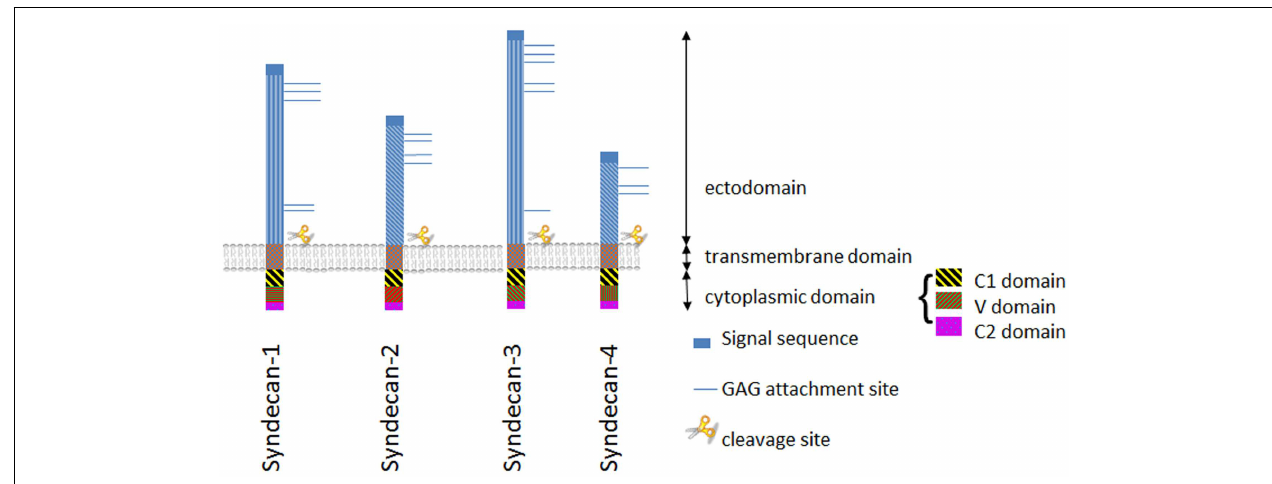
variable with the exception of the GAG attachment sites and the proteolytic cleavage site near the plasma membrane. In contrast the endo- and transmembrane domains are well preserved.